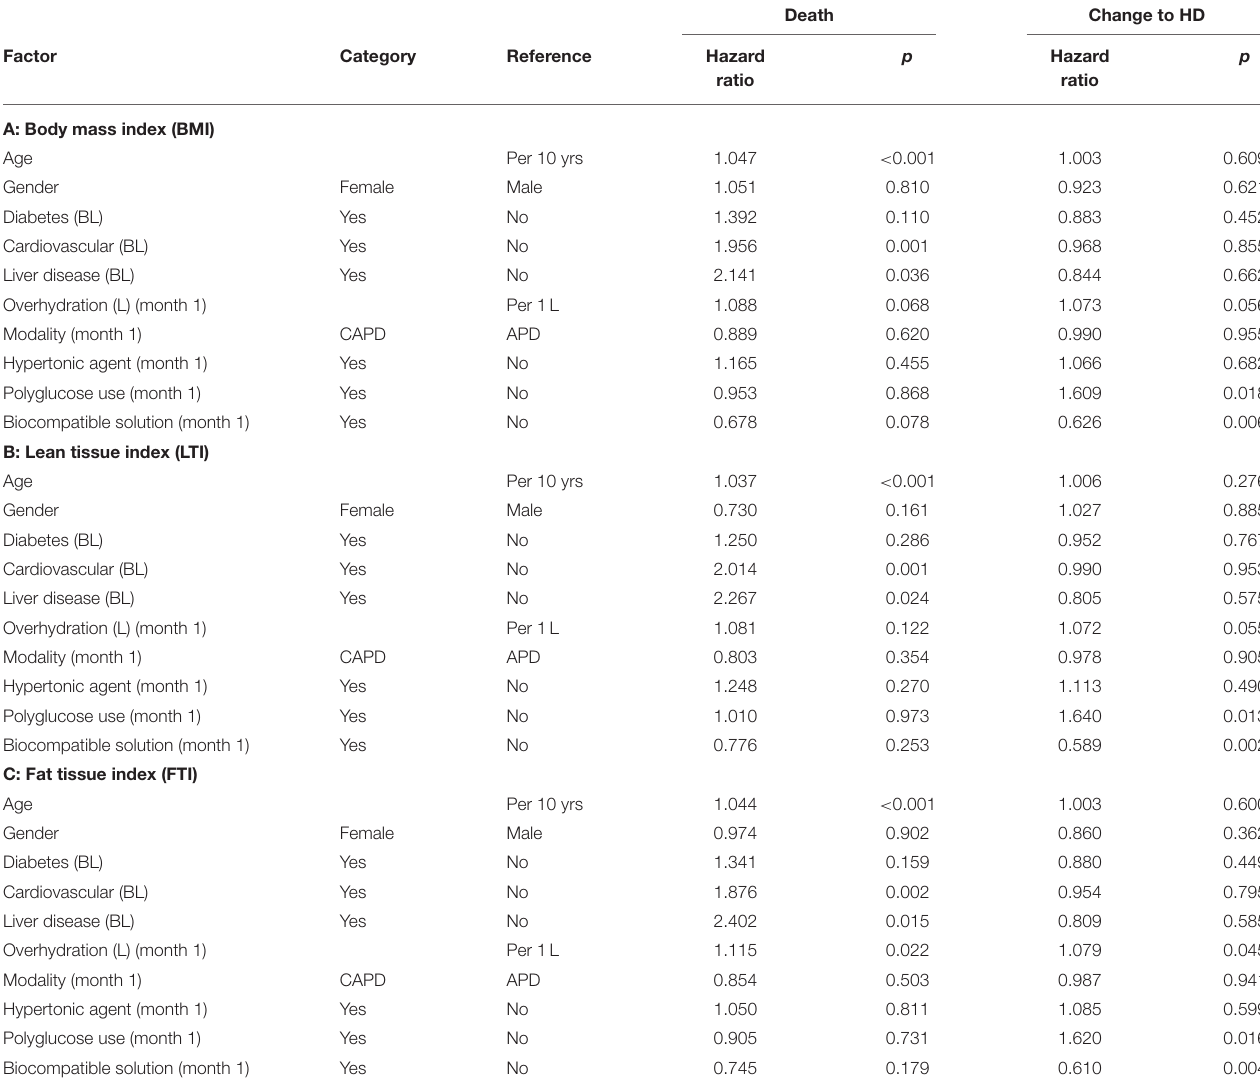
TABLE 5 | Competing risk analysis on the influence of covariates together with body mass index (BMI) (A), LTI (B), FTI (C) on the event of “death” or “change to hemodialysis (HD);” BL: Baseline.